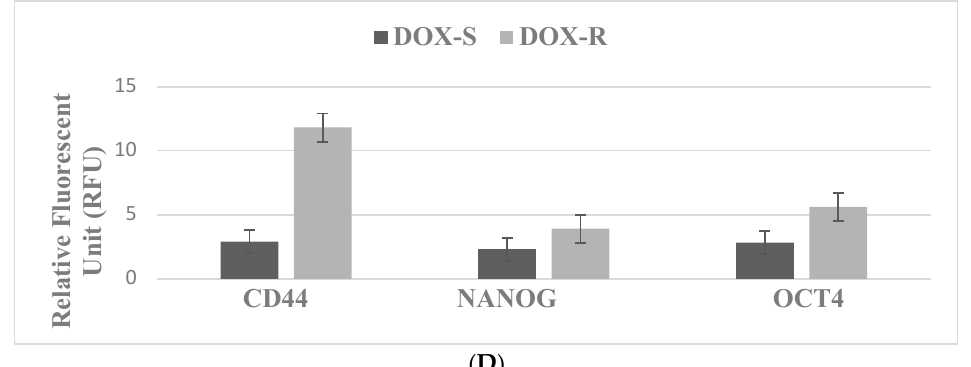
Figure 1. ( A ) Status of tumor spheroid formation. In the presence of cytotoxic drugs, the drug- resistant (R) phenotypes exhibit increased numbers of tumor spheroids relative to their respective drug-sensitive (S) counterparts. TAM, tamoxifen; LAP, lapatinib; DOX, doxorubicin. Status of stem cell markers in drug-resistant phenotypes. ( B ) The expression of CD44, NANOG and OCT-4 in the resistant TAM-R phenotype is increased relative to the sensitive TAM-S phenotype. ( C ) The expression of CD44, NANOG and OCT-4 is increased in the resistant LAP-R phenotype relative to the sensitive LAP-S phenotype. ( D ) The expression of CD44, NANOG and OCT-4 is increased in the resistant DOX-R phenotype relative to the sensitive DOX-S phenotype. CD44, cluster of differentiation 44; NANOG, homeobox transcription factor; OCT-4, octamer-binding transcription factor-4; TAM, tamoxifen; LAP, lapatinib; DOX, doxorubicin.